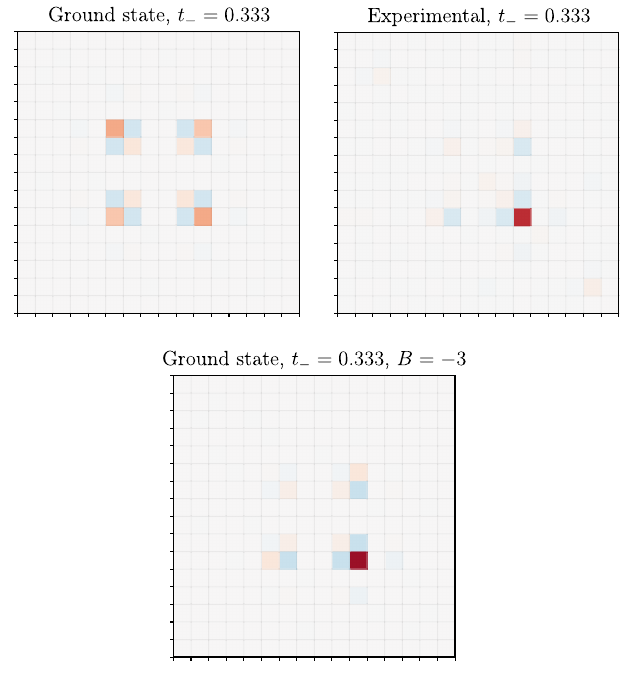
FIG. 9. Reduced density matrices of the four central ions in an eight-ion system. The top left state corresponds to the ground state at t − ¼ 0 . 333 . The experimentally measured data for same t − are shown in the right top state. In the bottom panel, we show the ground state of the ESSH model with a pinned magnetic field B ¼ − 3 [see Eq. 12] for t 0 . 333 , which is in good agreement − ¼ with the experimental data.